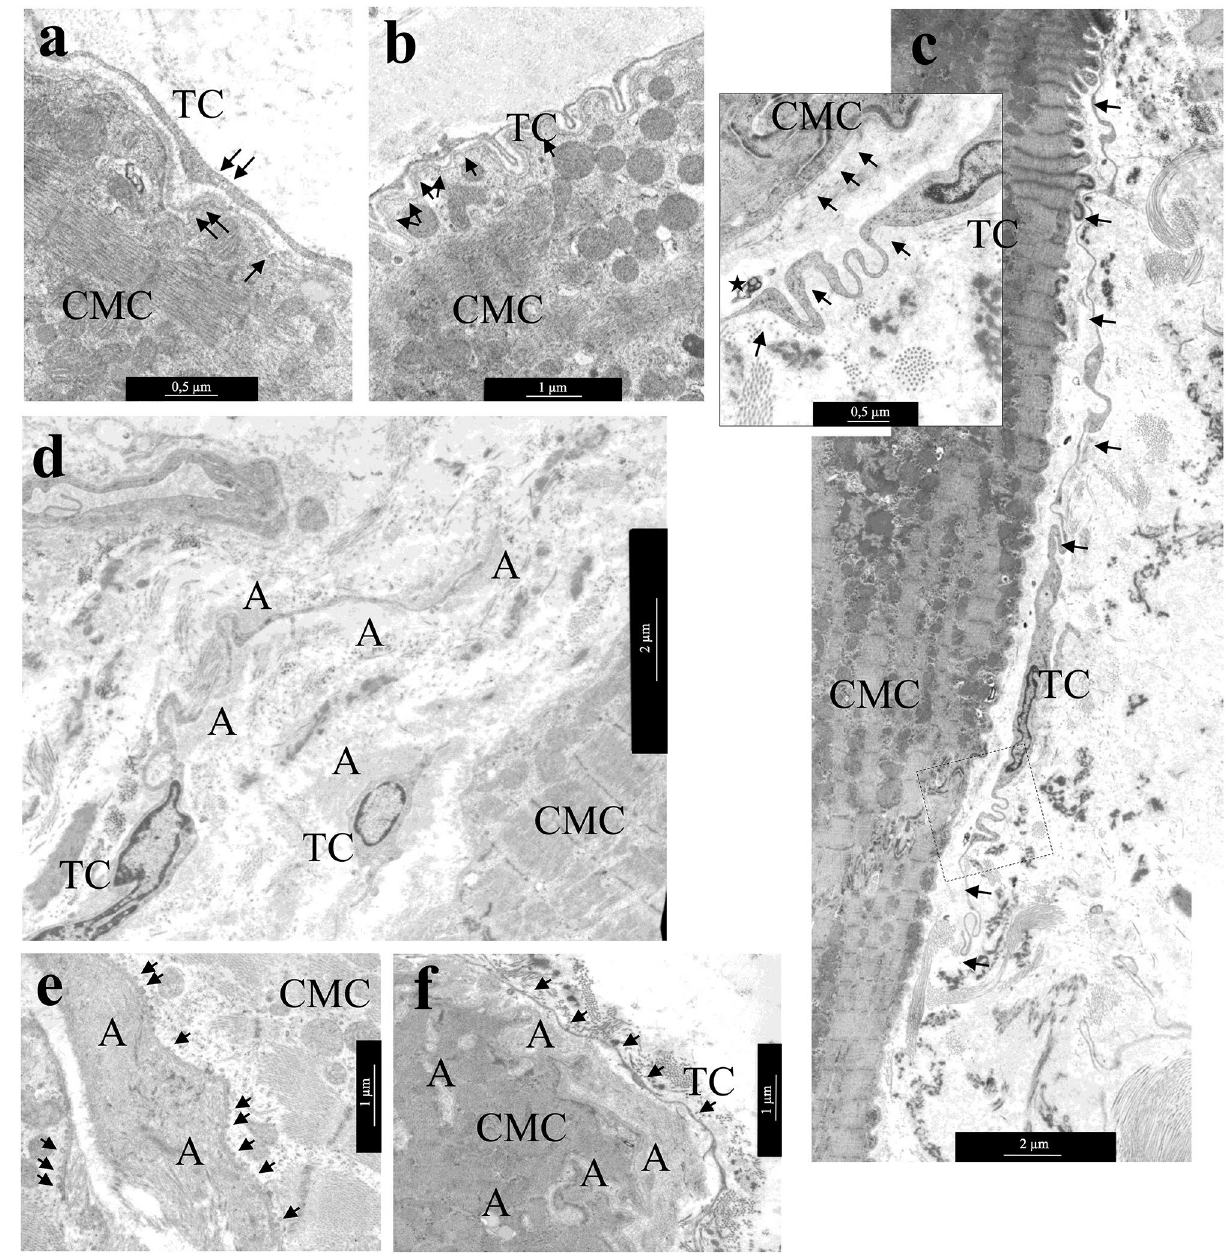
Figure 5. Distance interactions of TCs and cardiomyocytes. ( a ) The caveolae in the membrane of cardiomyocyte and TC process (arrows). bar 500 nm. ( b ) The process of TC follows all surface curves and is distributed in the invagination of the T-system of cardiomyocytes. Note the caveolae on the sarcolemma of a cardiomyocyte (arrows). bar 1 µm. ( c ) TC with extended Tps (arrows) located along the cardiomyocyte surface. bar 2 µm. Insert—Several caveolae on the surface of cardiomyocyte and TC (arrows). A multivesicular body (asterisk) in the interstitium next to the process of the TC. bar 500 nm. ( d–f ) TCs in areas of amyloidosis. ( d ) TCs and their processes are surrounded by amyloid fibrils. bar 2 µm. ( e ) Accumulation of amyloid fibrils on the surface of the cardiomyocyte membrane. Multiple vesicles (arrows) on the inner surface of the sarcolemma of the cardiomyocyte. ( f ) Amyloid fibrillar deposits on the surface of the cardiomyocyte membrane and in invaginations of the T-system of the cardiomyocyte. The TC process (arrows) at a distance from the cardiomyocyte membrane. ( e , f )—bar 1 µm. TEM. TC—telocyte, CMC—cardiomyocyte, A—amyloid